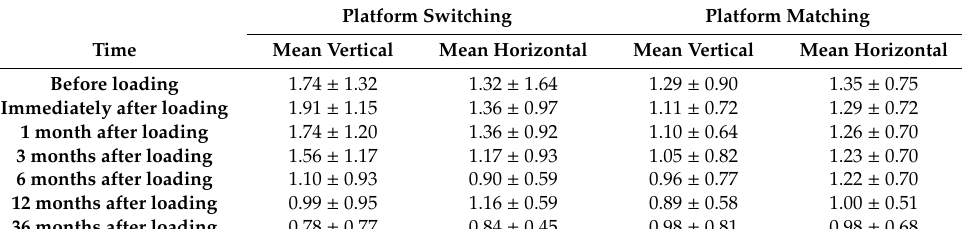
Table 2. Marginal bone level for PS and PM implants at di ff erent time points (mean ± SD mm). Platform Switching Platform Matching